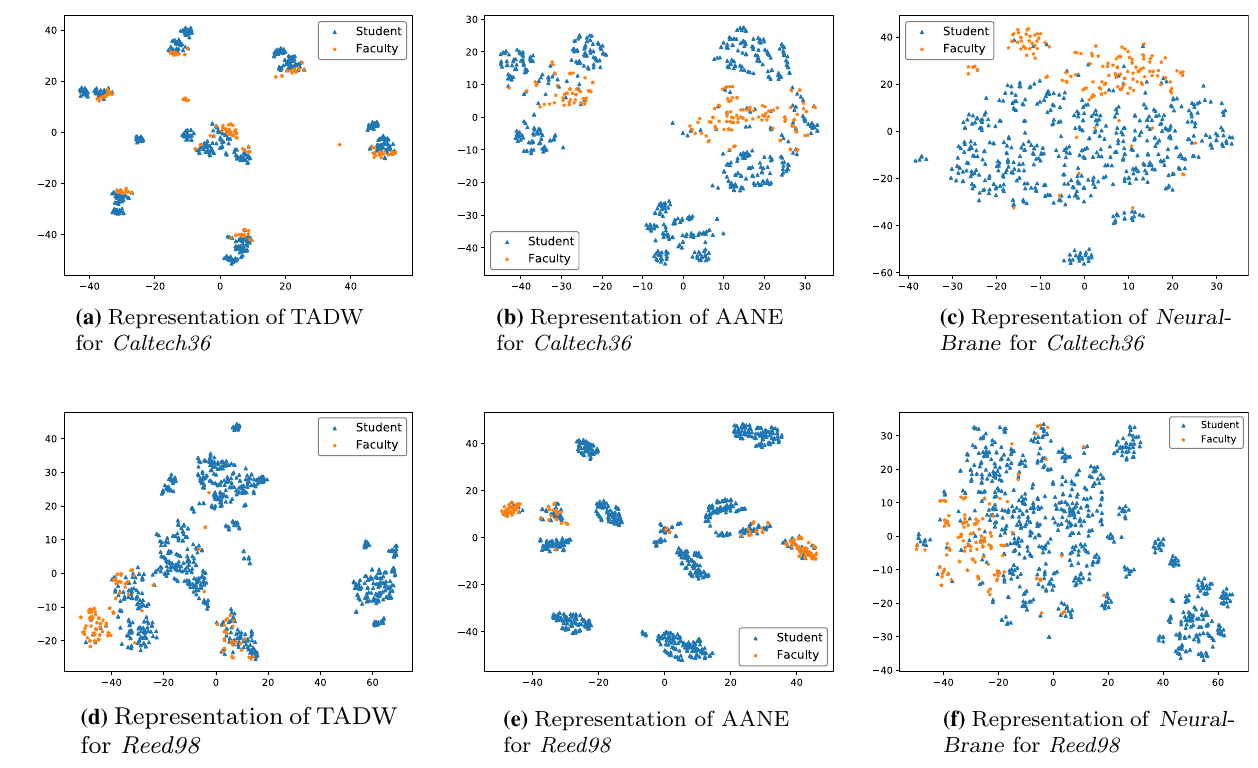
Fig. 3 Visualization comparison among various embedding methodologies for Caltech36 and Reed98